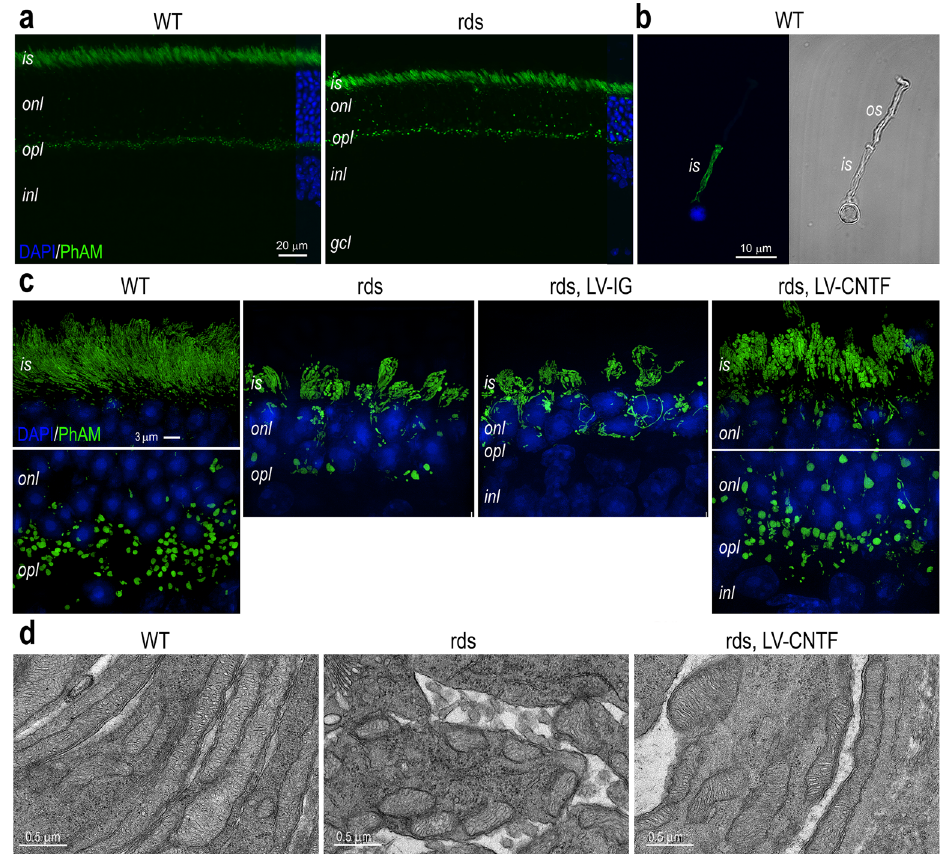
Fig. 1 | CNTF-induced mitochondrial morphological changes in rod photo- receptors. a Confocal microscopy images of P70 WT and rds retinas with the mitochondrialPhAMreporteractivatedinrodphotoreceptors. b AdissociatedP35 WT rod photoreceptor with PhAM reporter shown as Airyscan fl uorescent image (left) and bright fi eld image (right). c SIM images show PhAM-labeled rod mito- chondria in WT, rds, and rds mutant injected with LV-IG or LV-CNTF at P28 and